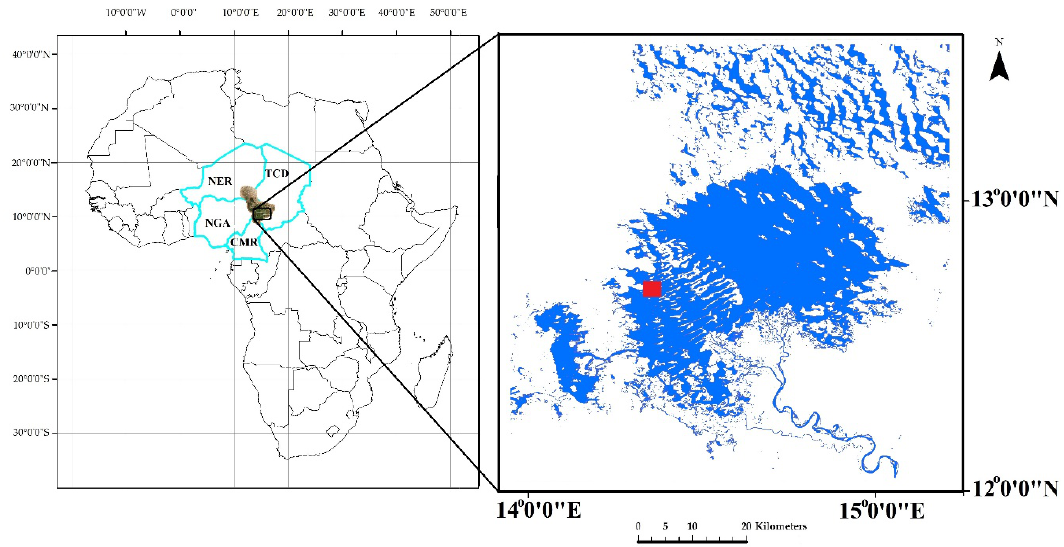
Figure 1. Study area. Image on the right represents water boundaries in the southern pool of Lake Chad which is the focus area in this study. Red square represents area where the performance evaluation of this study was carried out.